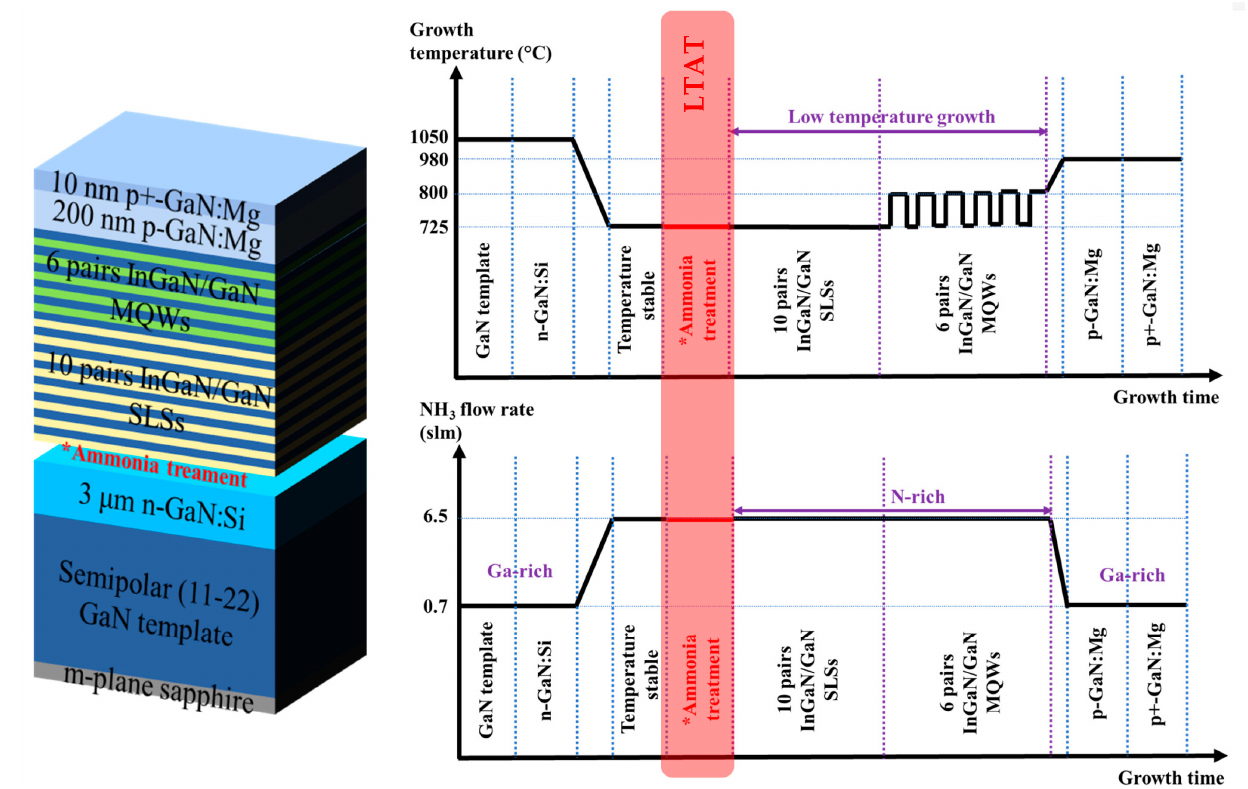
Figure 1. Schematic diagram, growth temperature profile and ammonia flow profile for the semi- polar (11–22) InGaN/GaN-based LED structure, and * indicating the LTAT step with ammonia treat- ment (LED A: with LTAT; LED B: without